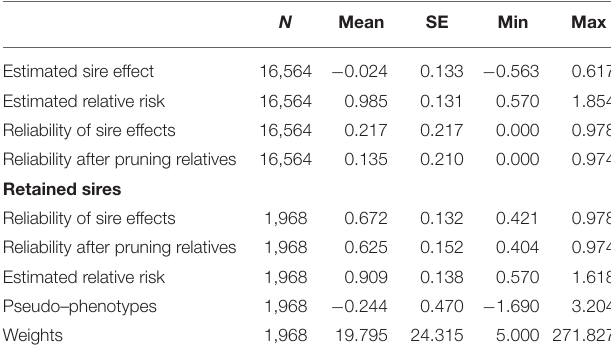
TABLE 2 | Statistics on the estimated sire effects for functional longevity in jumping competition and for sires retained for the calculation of